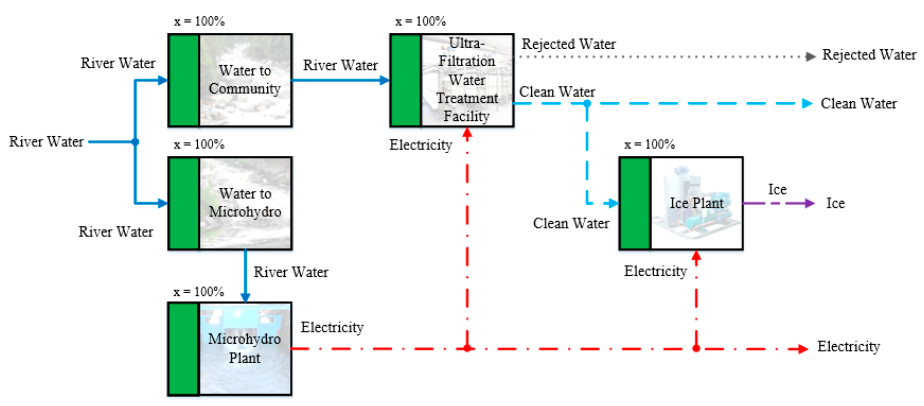
Figure 2. The process flowsheet of the polygeneration system of case study 1.